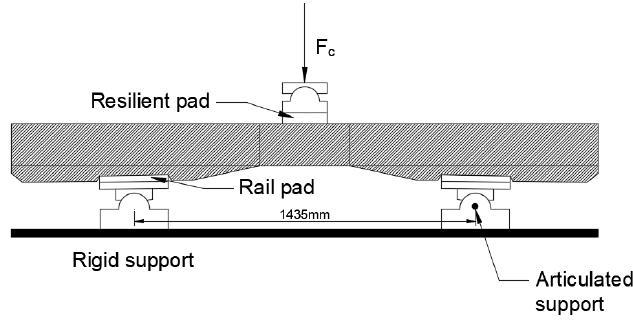
Figure 2. Setup of the static capacity test of the railway sleeper.